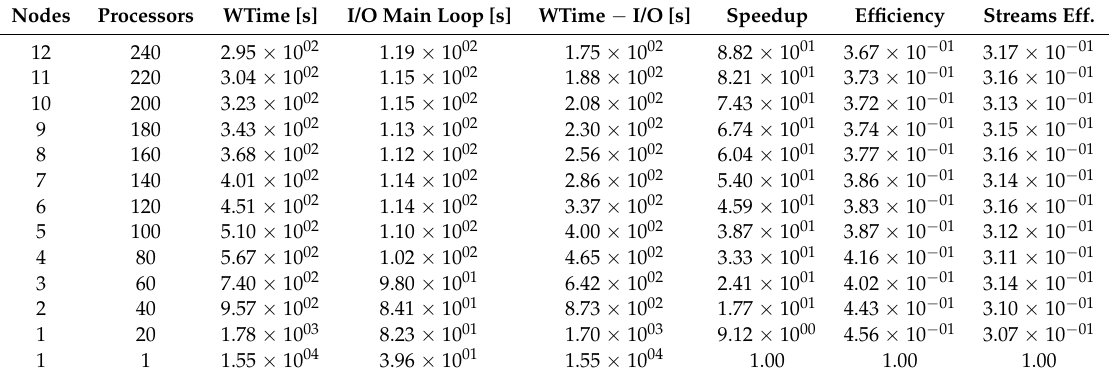
Table A3. Parallel performance of the high resolution stratified seamount experiment (3000 × 200 × 100) in the COD system.